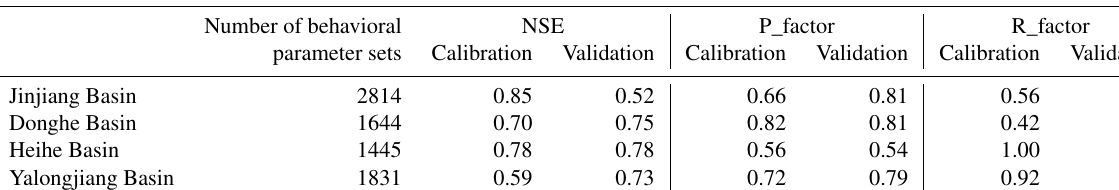
Table 5. Model performance for the benchmark calibration in the four basins.